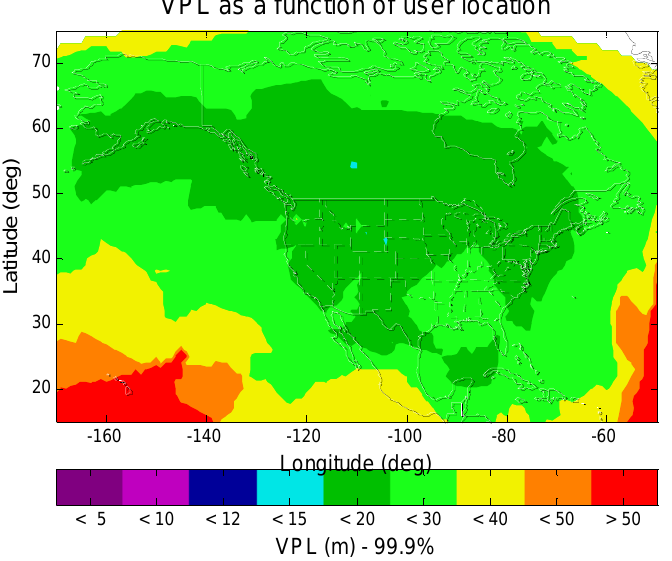
Figure 7. The 99.9% VPL contour of the L1-L5 dual-frequency GPS/WAAS user avionics sensor. The VPL values in most of CONUS, Alaska, and Canada are less than 20 m (APV II